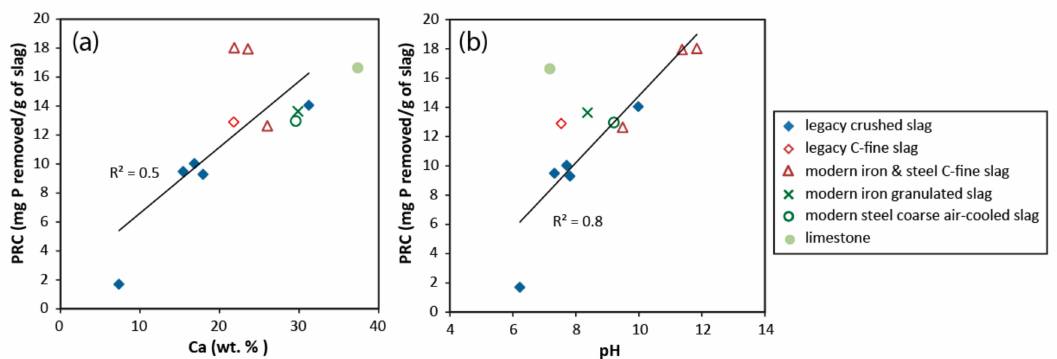
Figure 5. Results from batch experiments using initial leachant phosphate concentration of 1085 mg P / L on slag from the Chicago-Gary area, Illinois and Indiana. ( a ) Phosphate removal capacity (PRC) versus bulk calcium (Ca) concentrations in weight percent (wt. %). ( b ) PRC versus pH of the reacted e ffl uent solution. The linear regression line and coe ffi cient of determination (R 2 ) are also